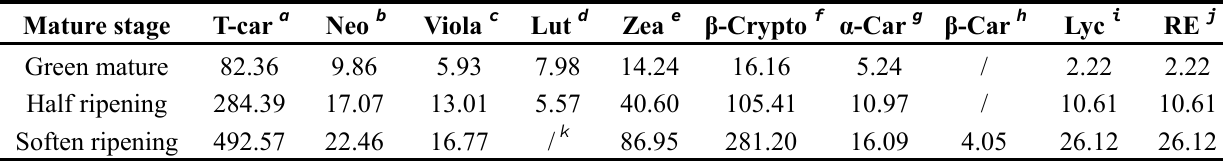
different stages of maturation ( μ g/100 g